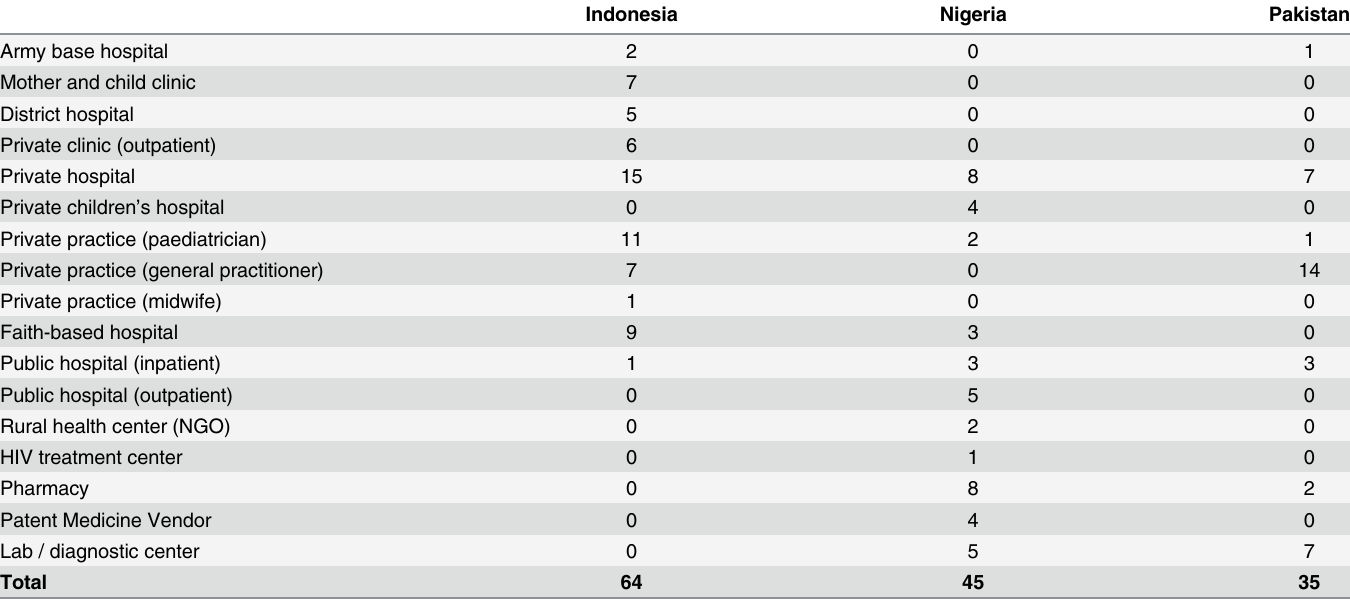
Table 1. Summary of Sites Visited, by Country and Facility